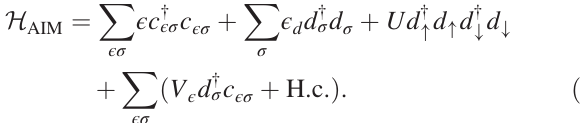
ε Þ as a function of ε ; d ↑ ; d † Fig. 3, showing S ½ d ↑ ; d † ↑ ↑ (cid:2)ð ε ε ε 2 at 3 ¼ 1 , with a layout analogous to Fig. 2. The rebinning artifacts, seen in Fig. 3(b) along the diagonal, are small as well. For example, the maximum magnitude of the